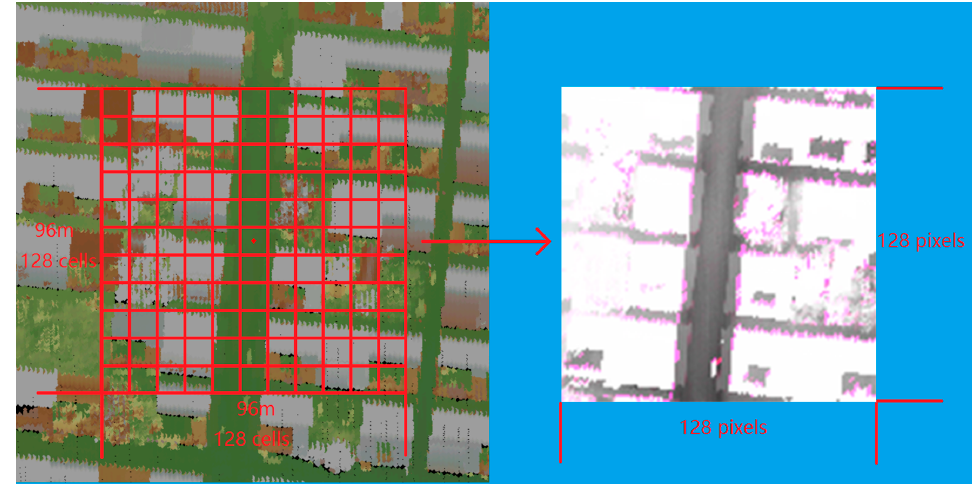
Figure 2. Point-to-image transformation (source: own study in the “FugroViewer”).